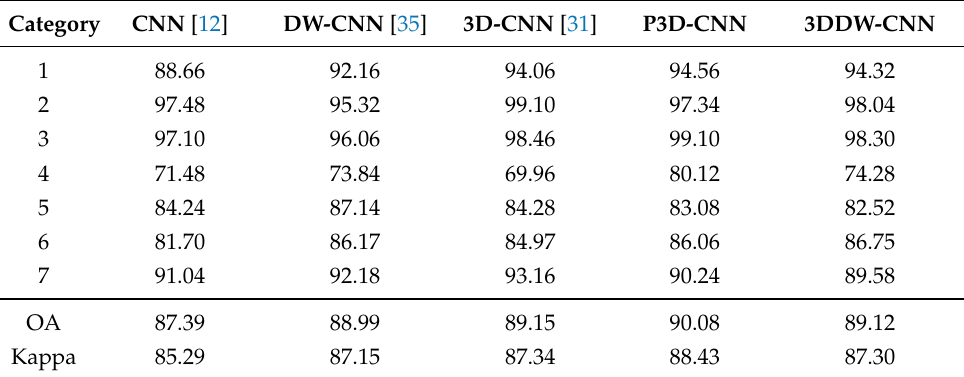
Table 7. Classification results (%) on the EMISAR Foulum dataset.